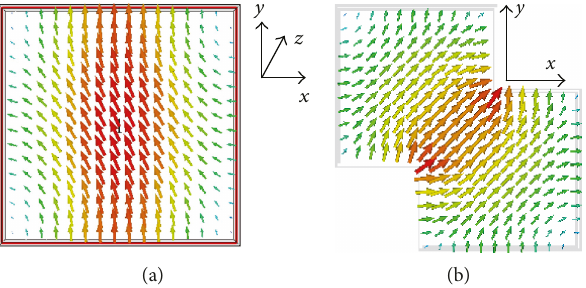
Figure 2: The electrical fi eld pattern of the in fi nite double-corner-cut waveguide. (a) Without the corner cut. (b) With the corner cut (mode TE 1 m